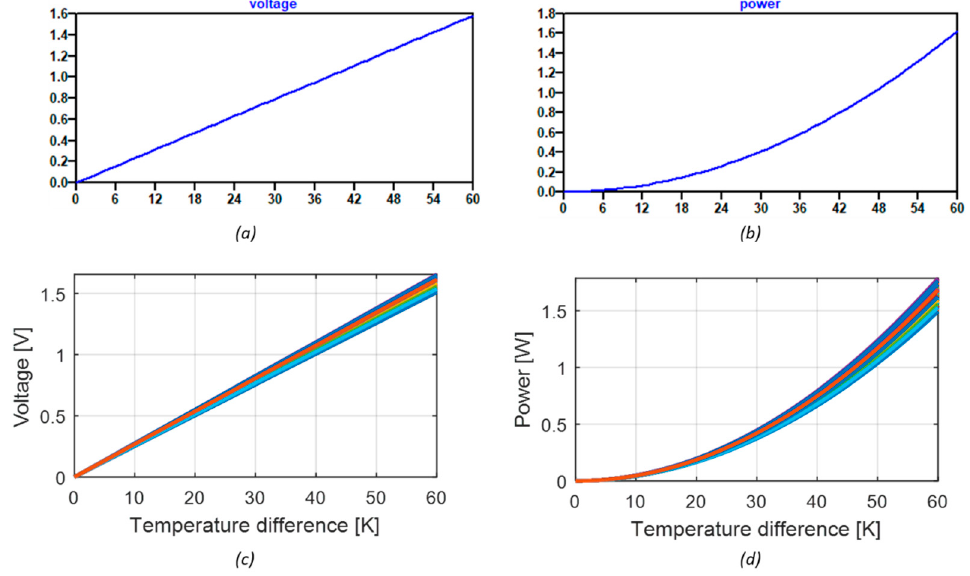
Figure 8. Simulation of TEG electrical model. ( a ) V MPP– ∆ T and ( b ) P MPP– ∆ T for mean internal parameters. ( c ) V MPP– ∆ T and ( d ) P MPP– ∆ T during the Montecarlo simulation.